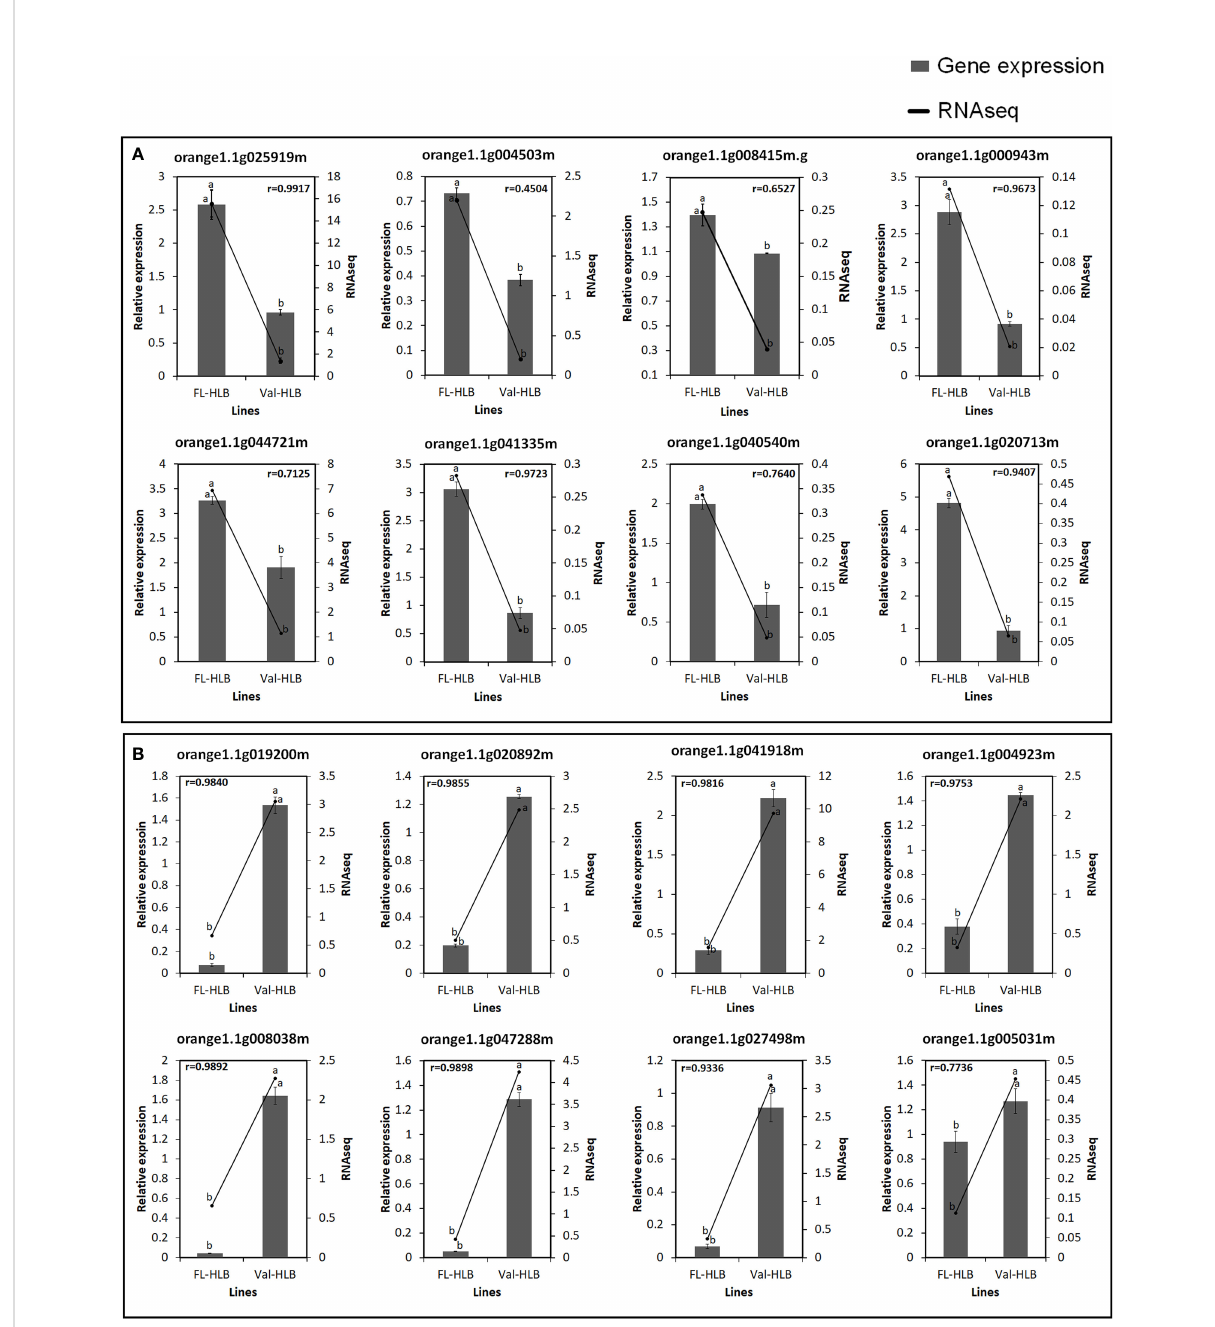
FIGURE 6 Veri fi cation of expression levels of selected upregulated (A) or downregulated (B) DEGs in the infected Finger lime (FL-HLB) compared to infected ‘ Valencia ’ (Val-HLB) as determined by qPCR (2- DD Ct). Different letters (a, b) represent a signi fi cant difference at p ≤ 0.05 using Tukey – Kramer honestly signi fi cant difference (HSD) and error bars represent SE (n = 3). Pearson Correlation Coef fi cient (r)> greater than 0.5 is considered positive and